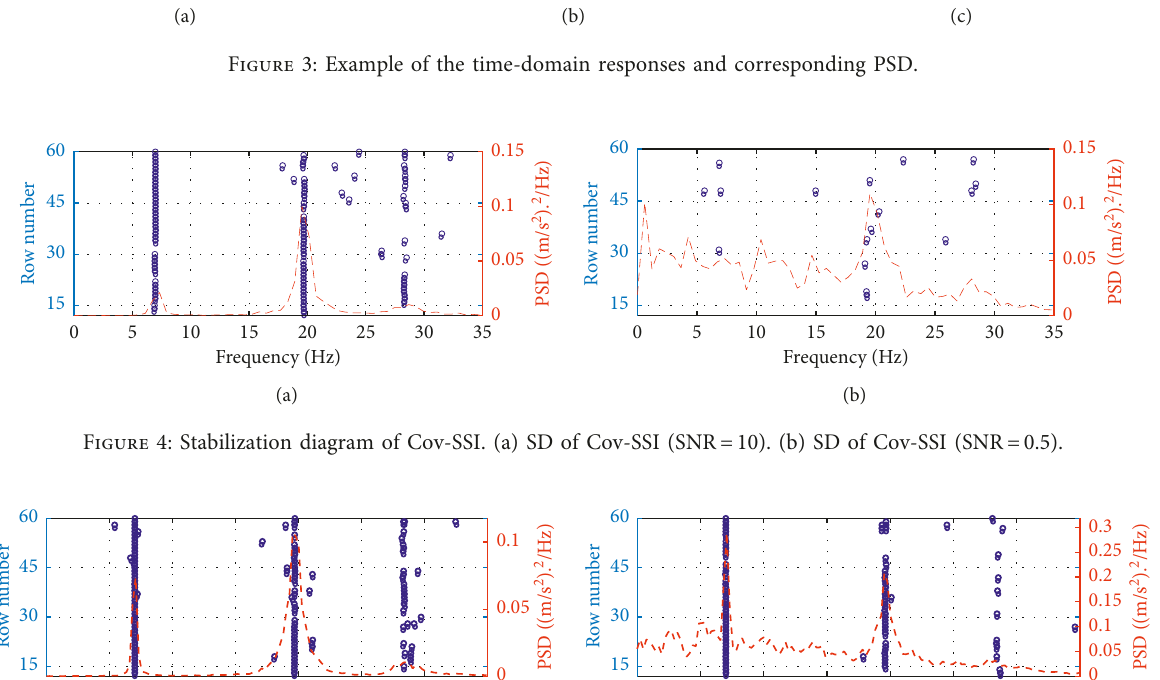
10). (b) SD of Cov-ACS (SNR (cid:31)